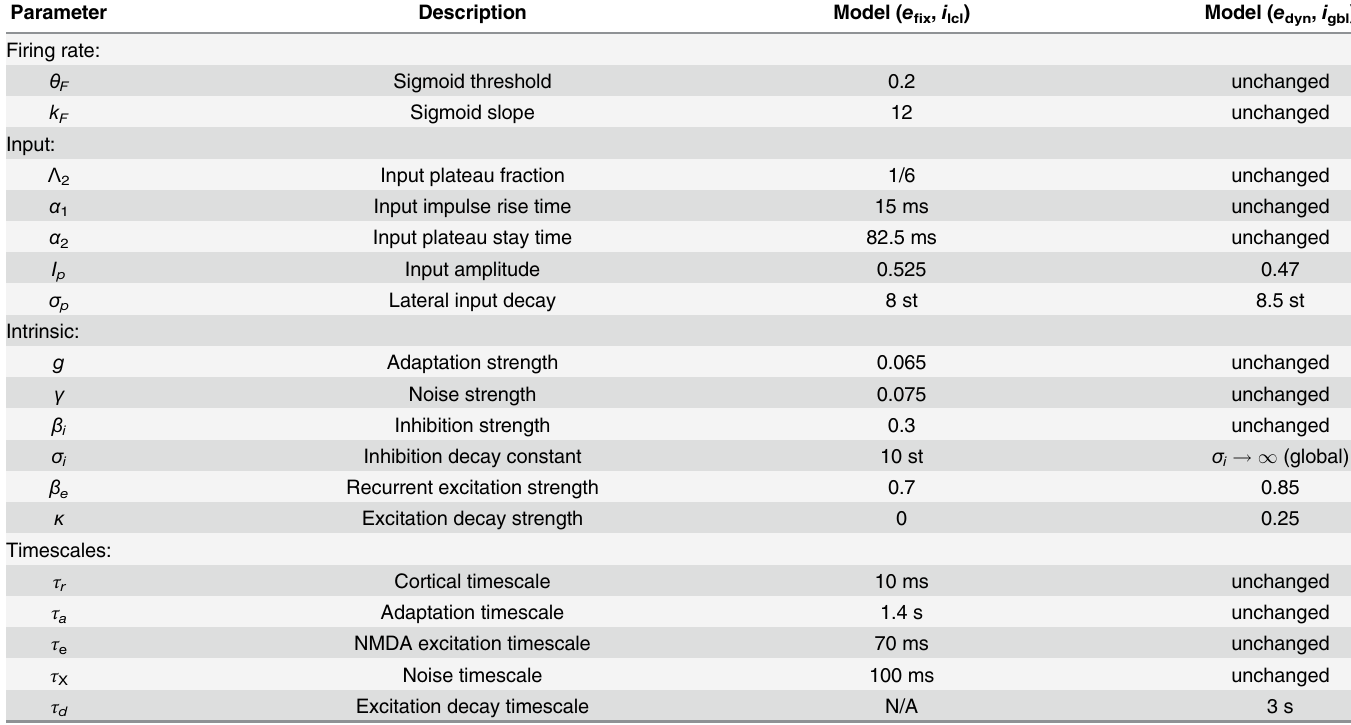
Table 1. Model parameters as defined in Neuromechanistic model of auditory bistability and forming part of the general model equations given in Eq (4).